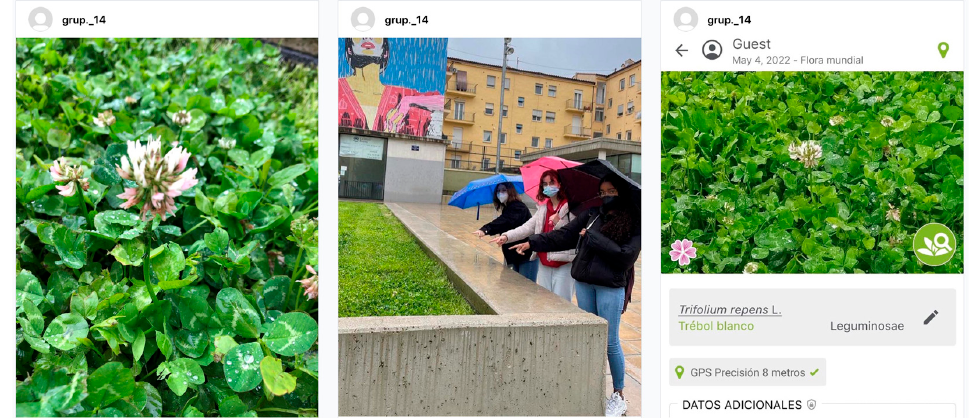
Figure A3. Example 1 of the test with the app: PlantNet. Notes: Hordeum murinum L. Wild bar- ley.